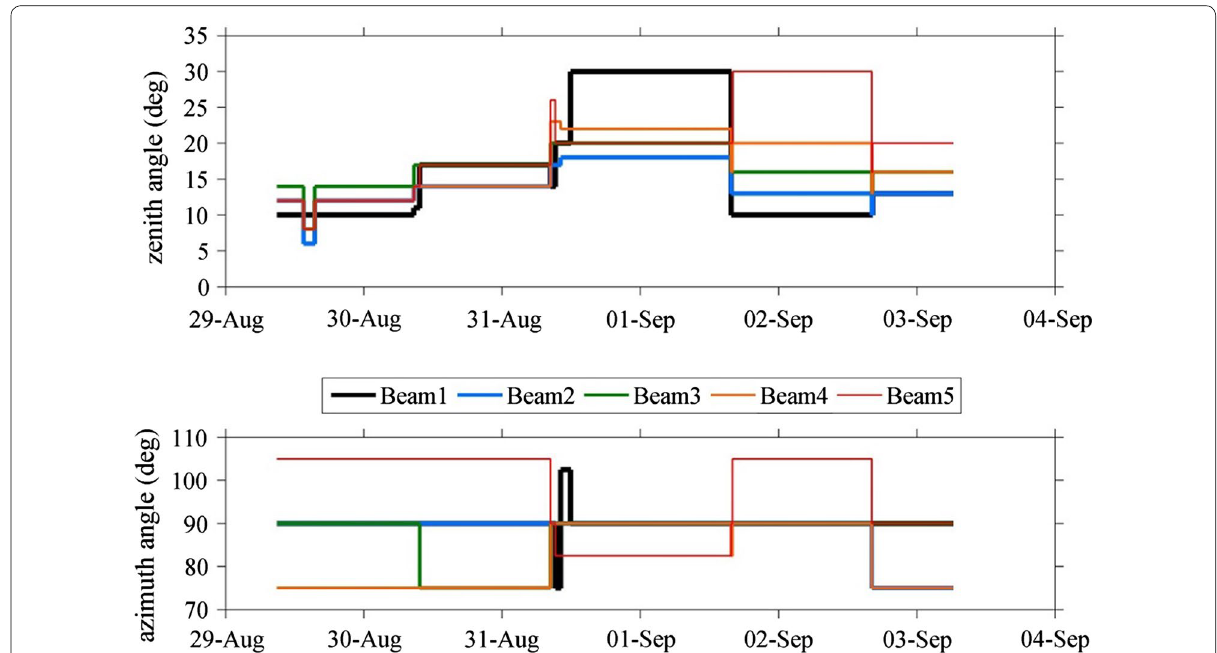
Fig. 12 Variation of zenith and azimuth angles during the EAR–RASS campaign from Aug 29 to Sep 3, 2016. Tick mark in the horizontal axis indi- cates 00:00 LT